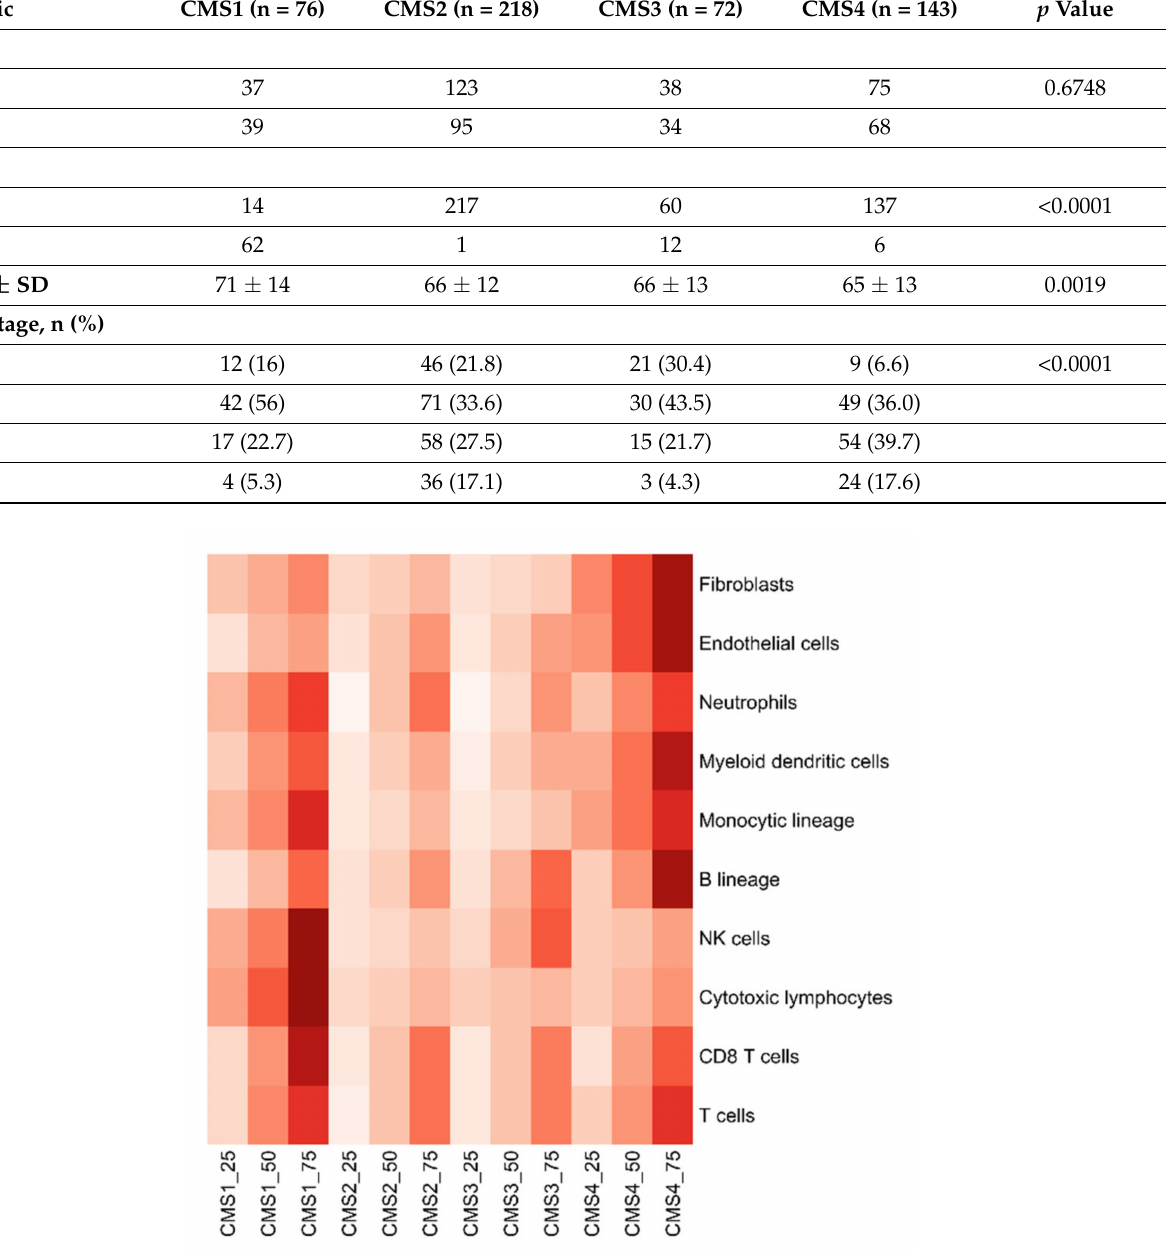
Figure 2. Ten tumor microenvironment cell populations for MCP-counter scores. CMS1 patients have significantly higher cytotoxic lymphocyte scores than the others. Each set of three columns represents one CMS subtype, each row represents the cell